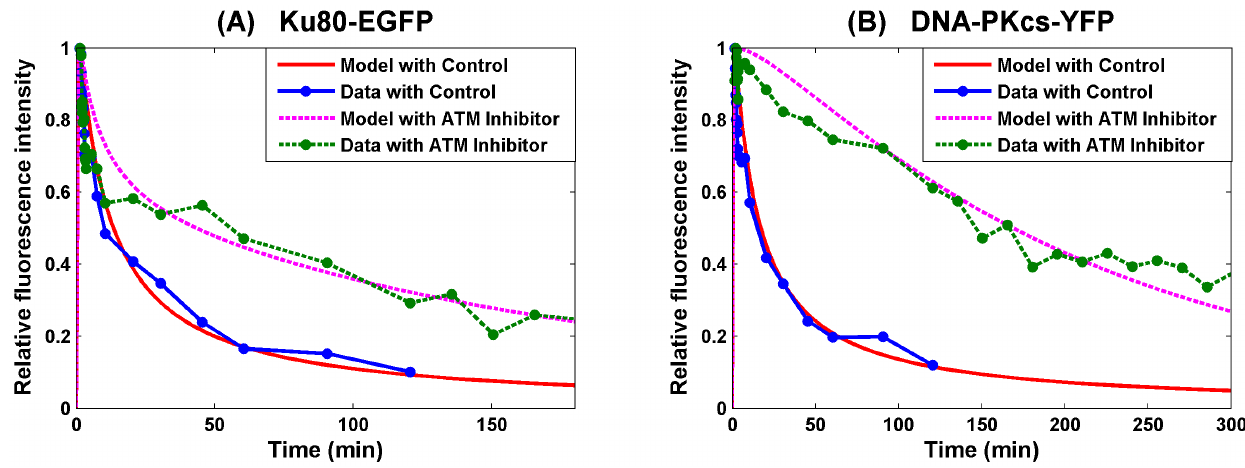
Figure 4. SF Model - Formation and loss of Ku80-EGFP and DNA-PKcs-YFP at the DSB in the radiation stripes with ends processing preceding synapsis formation. Panel (A) is for Ku80-EGFP and panel (B) for DNA-PKcs-YFP. The lines with dots are experimental data from [1], and those without dots are numerical simulation of the model. The solid lines are represent calculated normalized fluorescence intensity of the respective fluorescently tagged proteins with control, and the dashed lines are with ATM inhibitor present.